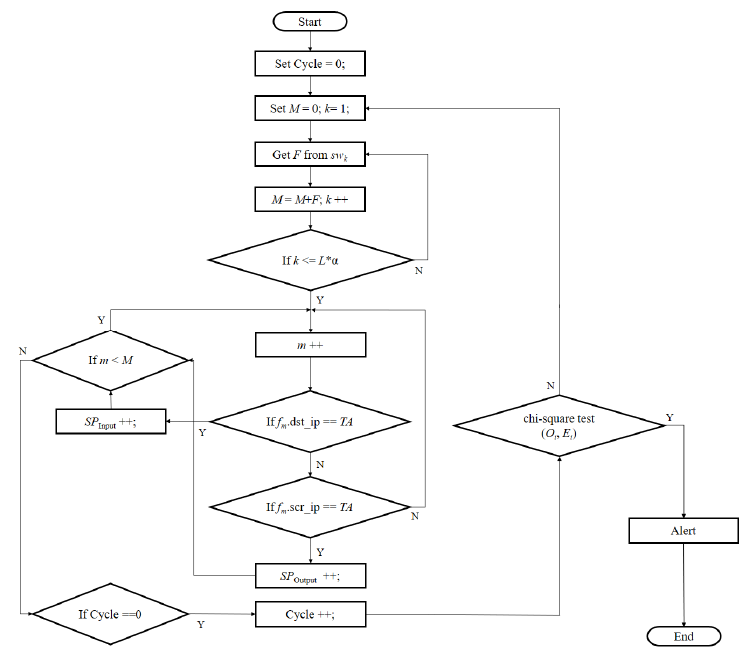
Figure 3. Flowchart of FDD